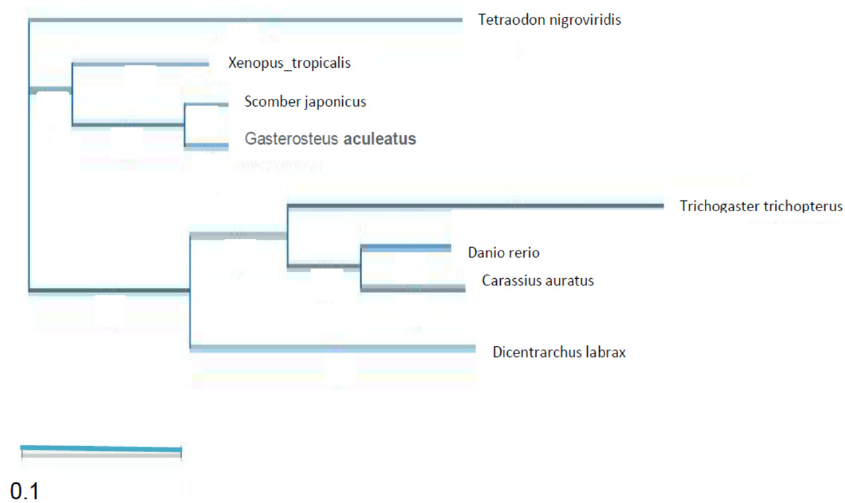
Figure 11. Phylogenetic tree showing the relationship between vertebrate Kiss2r amino acid sequences. The tree was generated by maximum Clustal W alignment in the MegAlign program (DNASTAR). Sequence alignment was conducted using DNA Star MegAlign Pro Clustal Omega. The Trichogaster trichopterus sequence was obtained from [29]. All other sequences were obtained from NCBI GenBank.